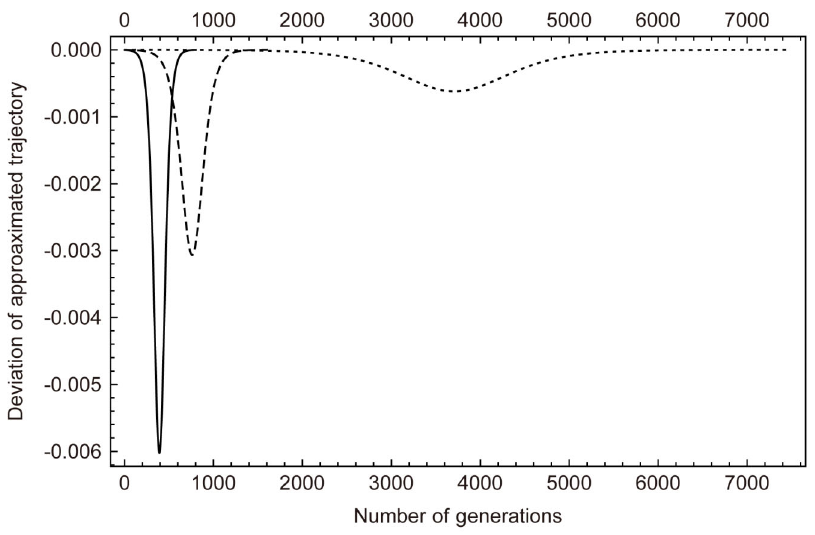
Figure 2. Deviation between HW approximated and real frequency trajectories of allele A . Solid line, dashed line, and dotted line are for selective coefficients s ~ 0 : 1, 0 : 05, 0 : 01 , respectively.